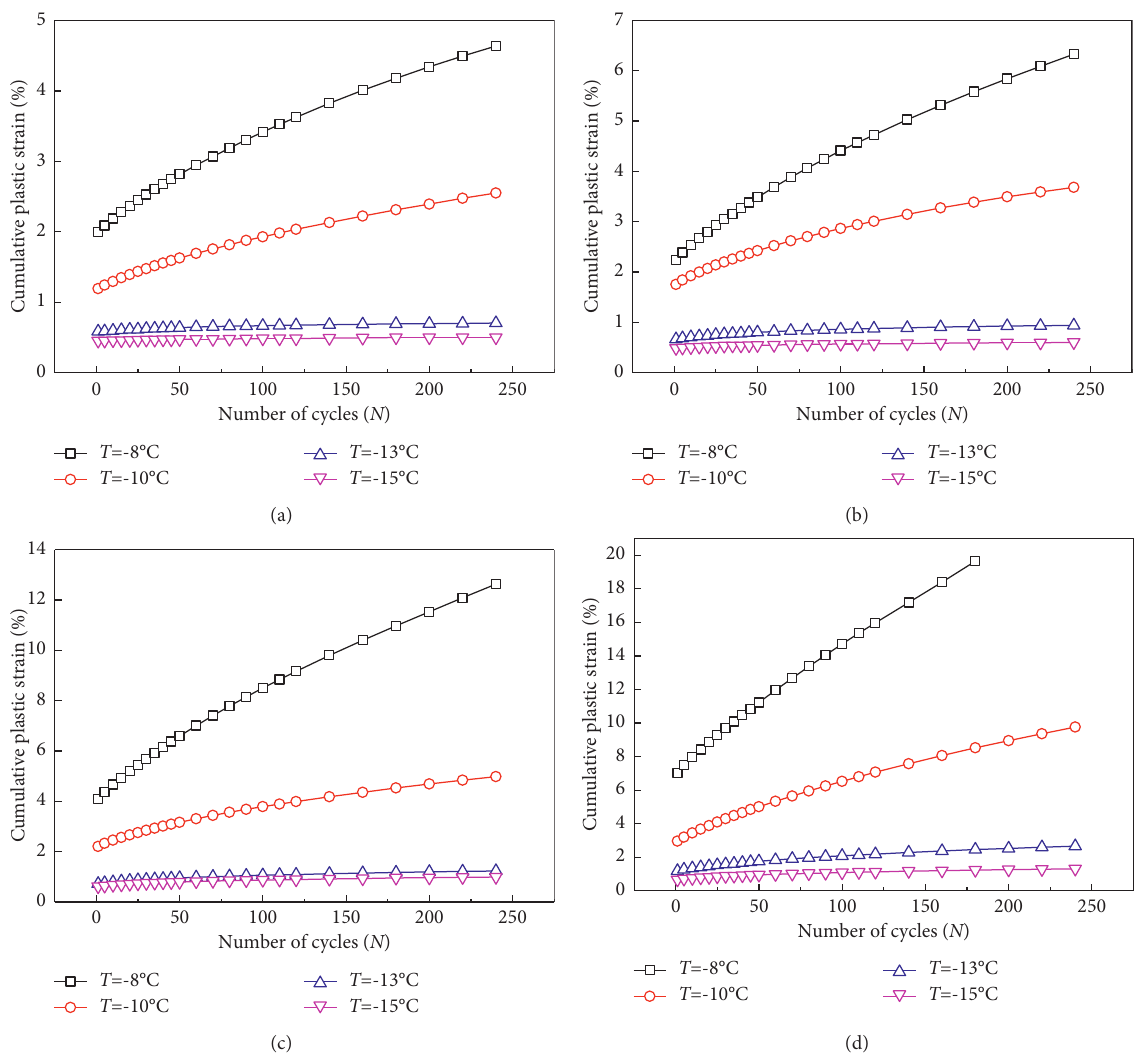
Figure 7: The evolution of the cumulative plastic strain versus the number of cycles at four temperatures and CSRs. (a) CSR � 0.225. (b) CSR � 0.300. (c) CSR � 0.375. (d) CSR �